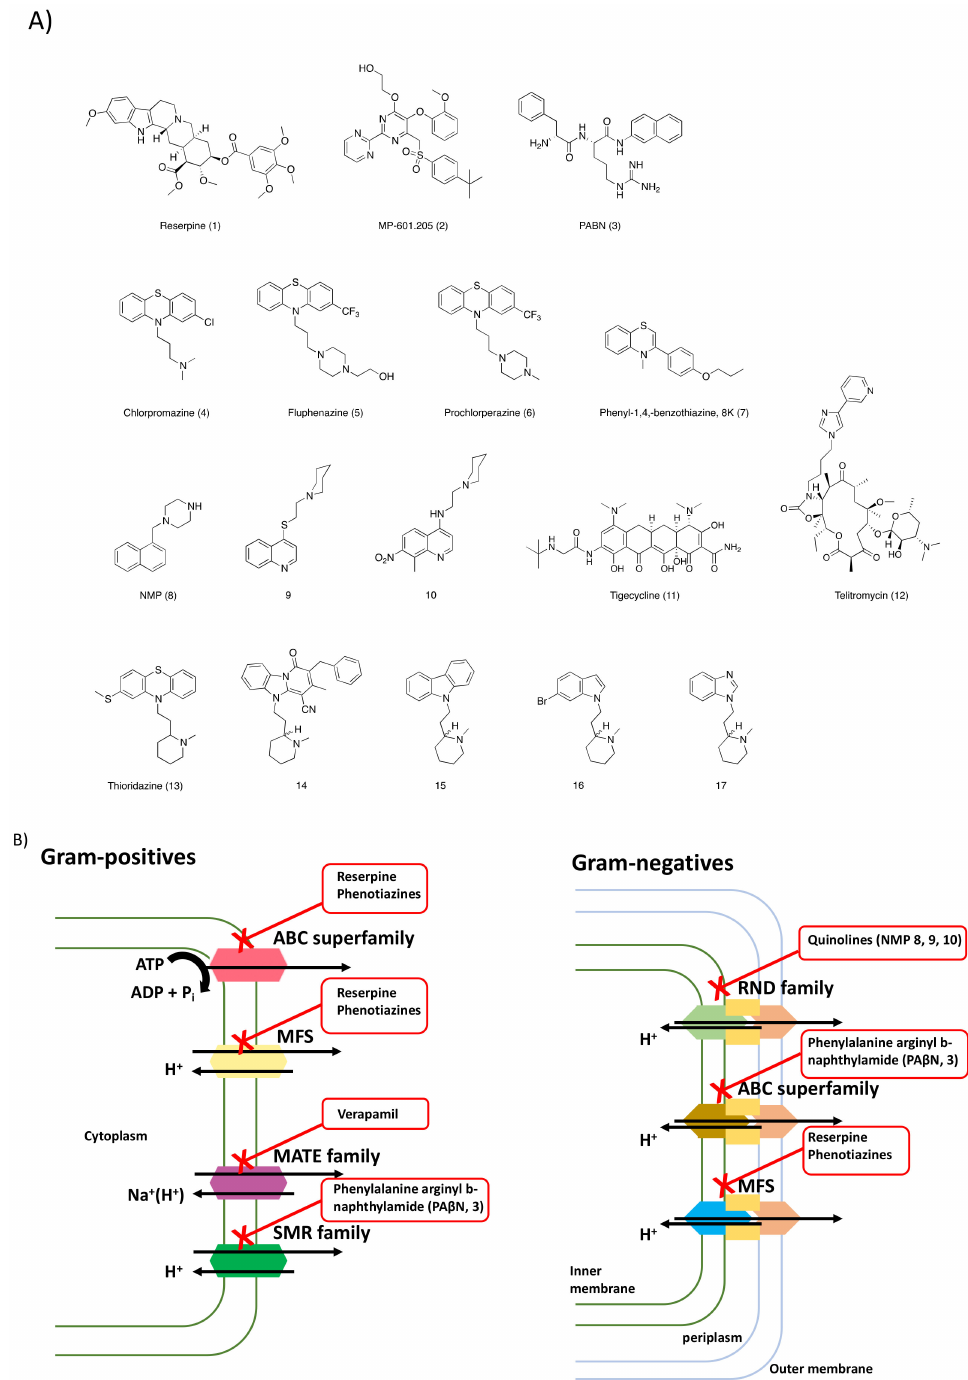
Figure 3. ( A ) Chemical structures of the e ffl ux pump inhibitors (EPIs) discussed in this review and ( B ) e ffl ux pumps expressed in Gram-positives and Gram-negatives bacteria and their respectively inhibitors. Similar e ff ects were described with the phenothiazines, calcium channel antagonists, selective inhibitors of serotonin reuptake, or proton pump inhibitors. Derivatives lacking the pharmacological activity of the cognate compound are now developed, as described for inhibitors of serotonin reuptake or of omeprazole. To date, the only documented inhibitor is currently MP-601 (2, Figure 3) administered as an aerosol in patients with ventilator-associated pneumonia or cystic fibrosis